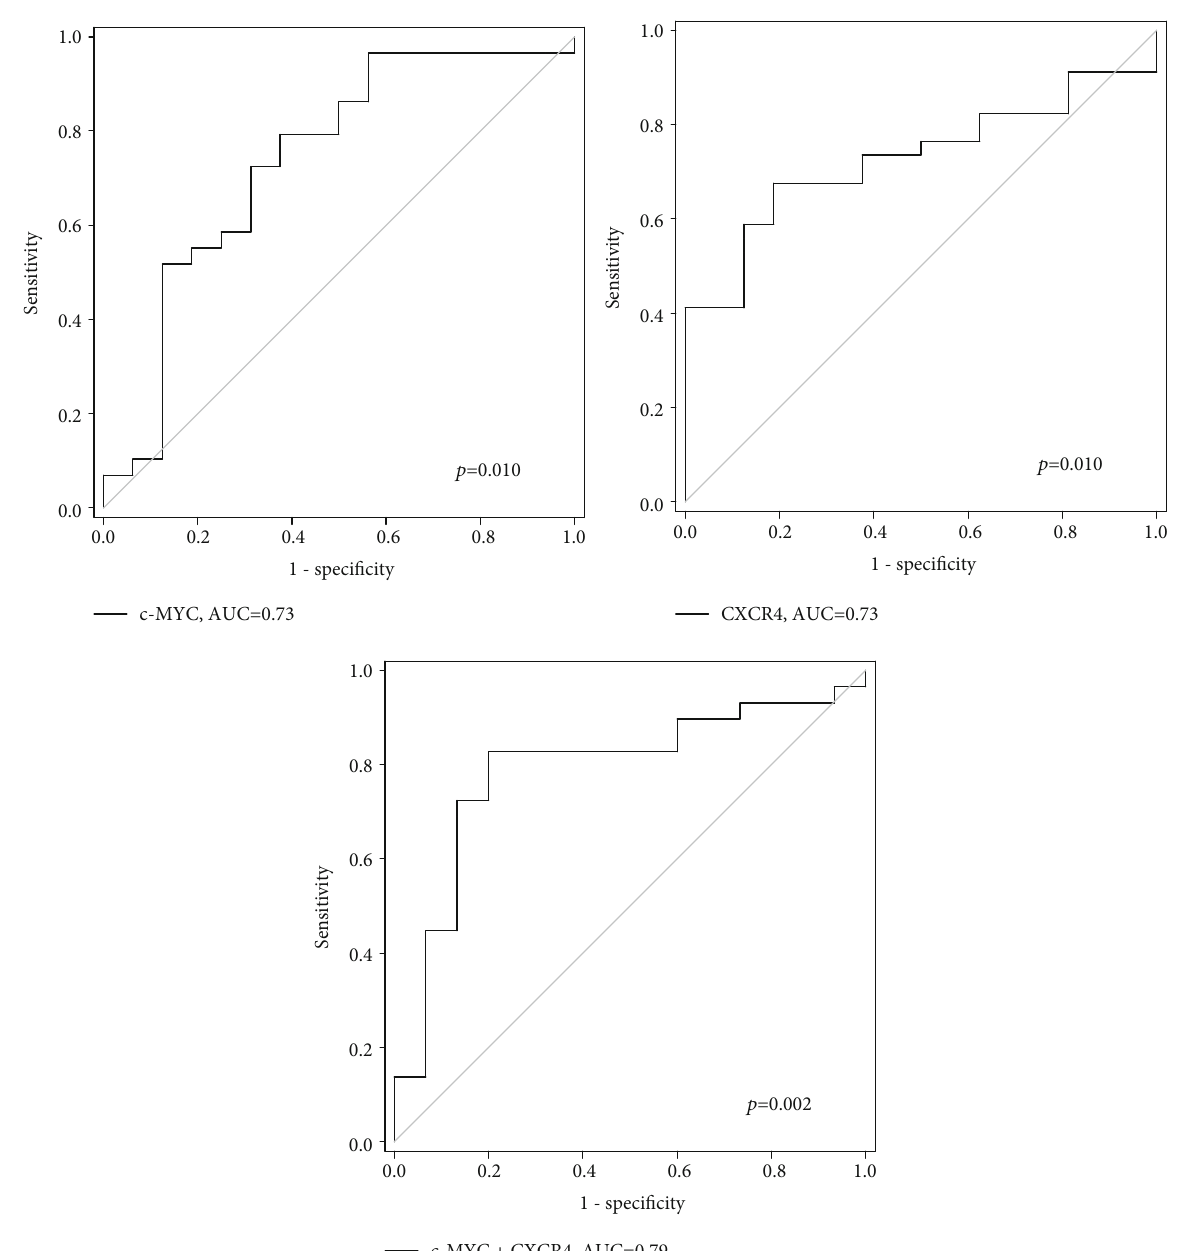
Figure 5: ROC analyses of c-MYC and CXCR4 and their combination for identi fi cation of CRC and polyp patients from normal